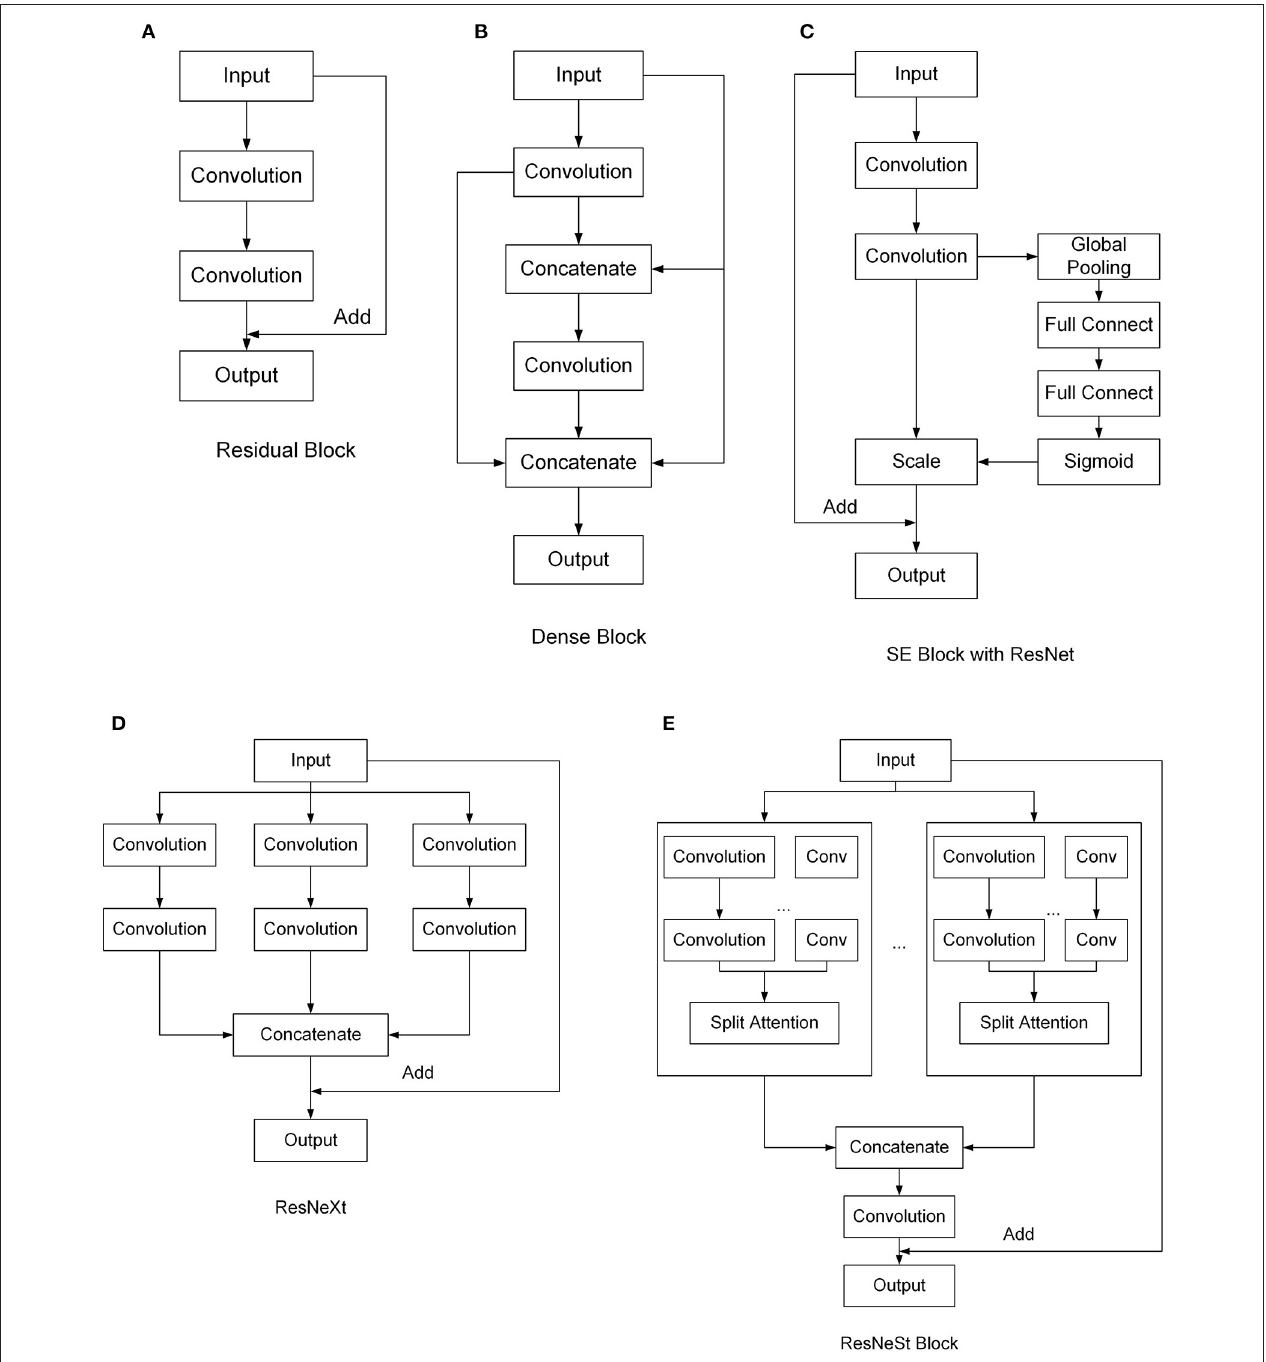
FIGURE 2 | Structures of different convolutional neural network (CNN) models tested. (A) Residual Block, (B) Dense Block, (C) SE Block with ResNet, (D) ResNeXt, (E) ResNeSt Block.